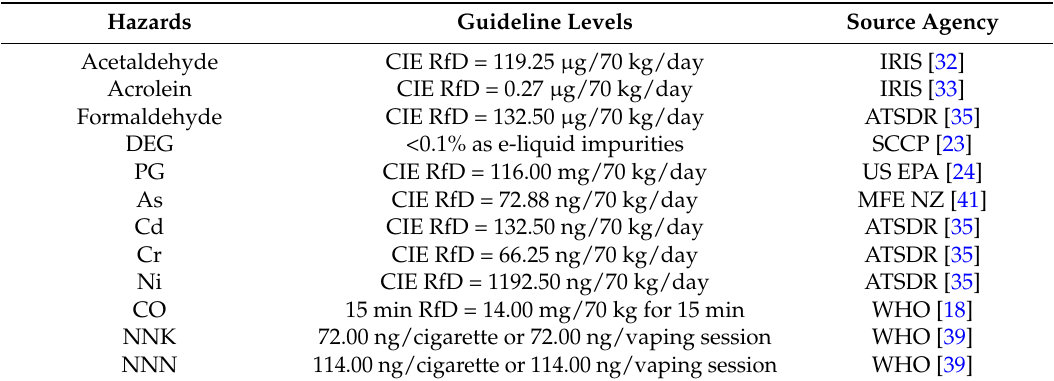
Table 2. Guideline levels of identified